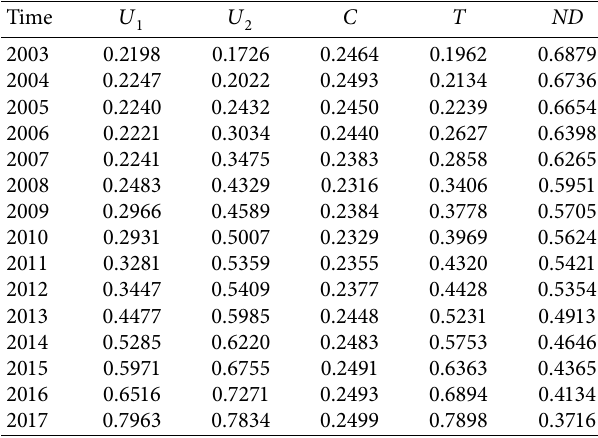
Table 3: The noncoordination coupling evaluation results between pro-poor tourism and eco-environment in Liupanshui city.